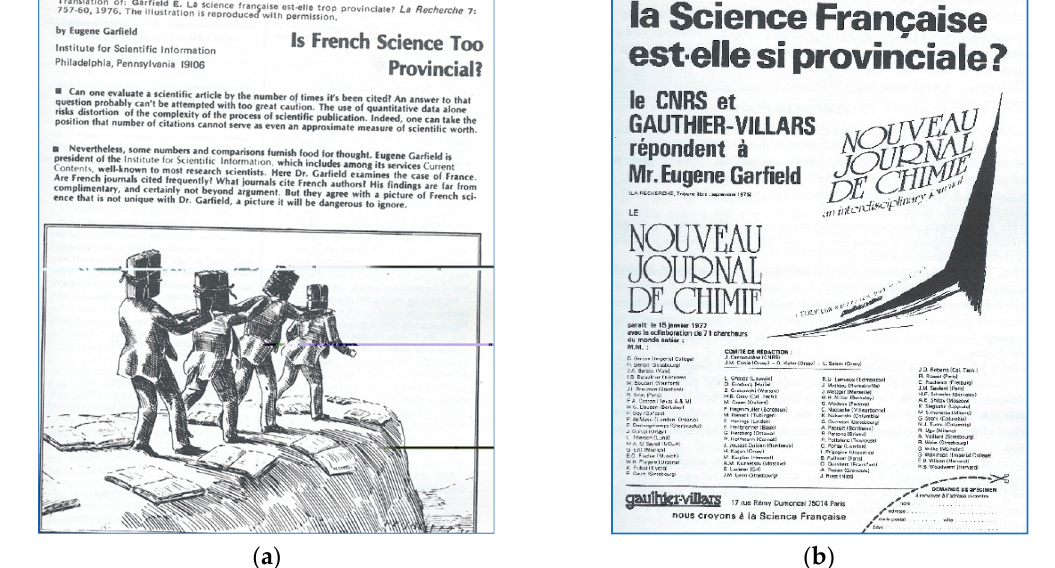
Figure 6. An article by Eugene Garfield promoting English as the international language of science published in The Scientist magazine. Reproduced with permission from The Scientist .